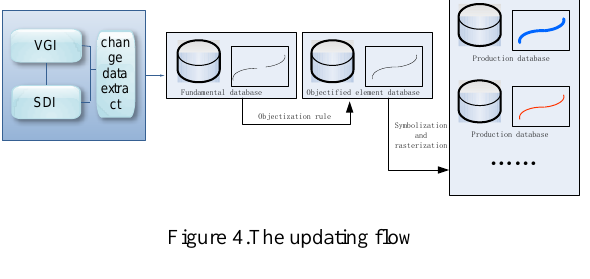
Figure 4.The updating